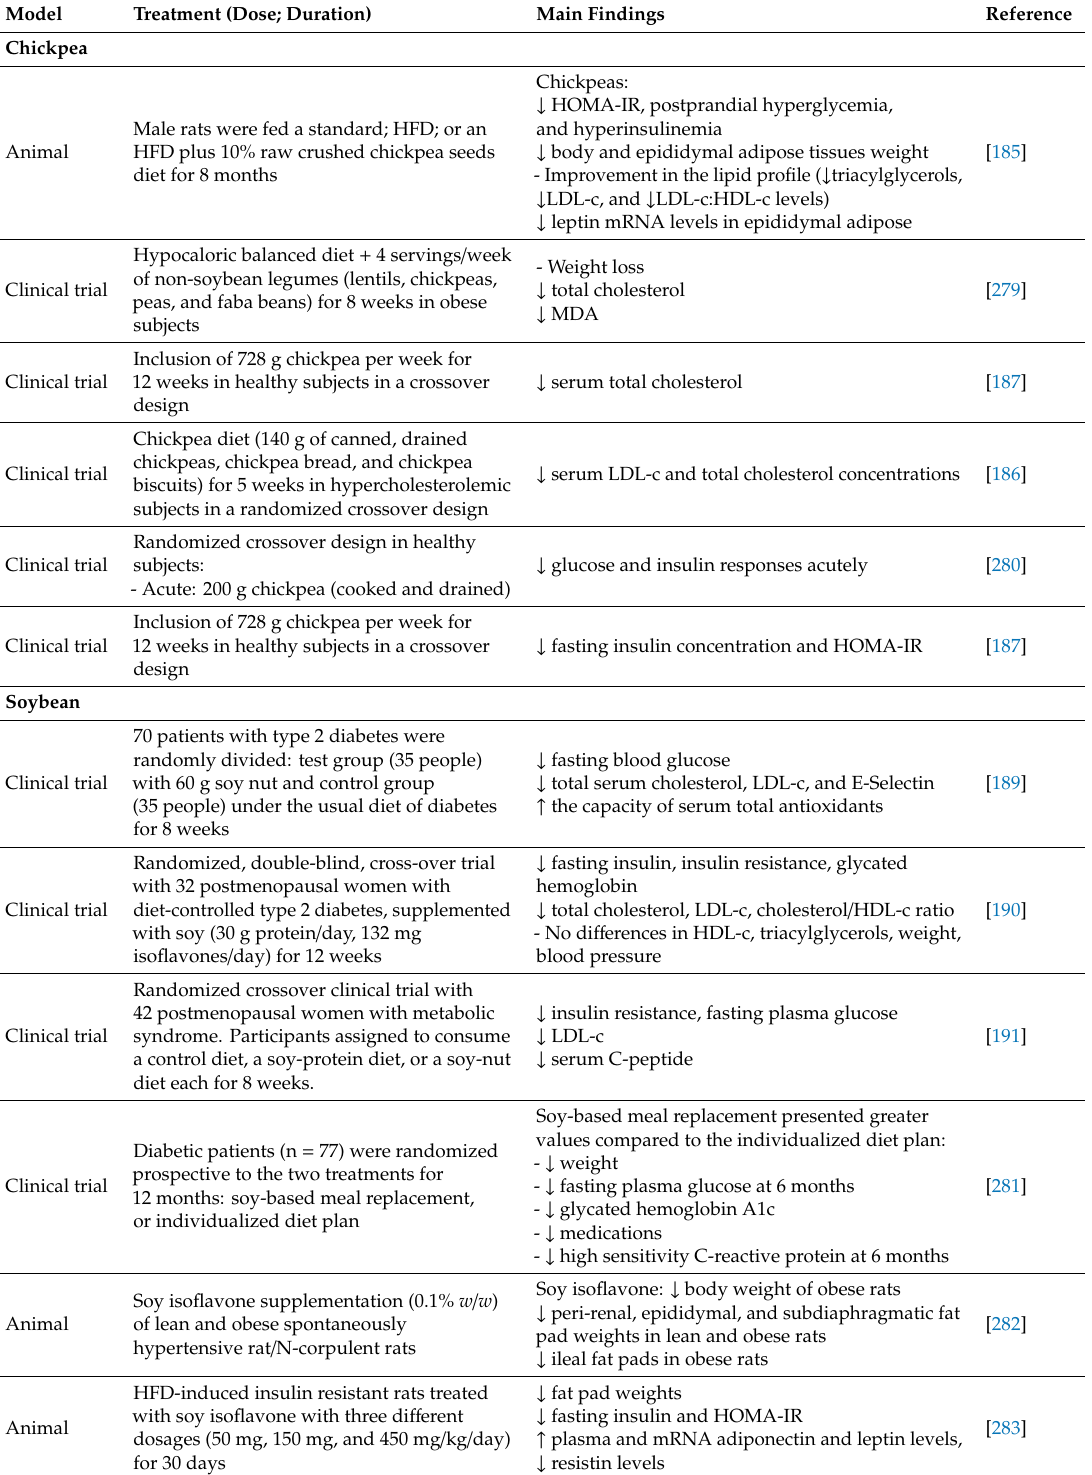
Table 9. Chickpea, soybean, and isoflavones in the prevention of type 2 diabetes and obesity and associated metabolic biomarkers in